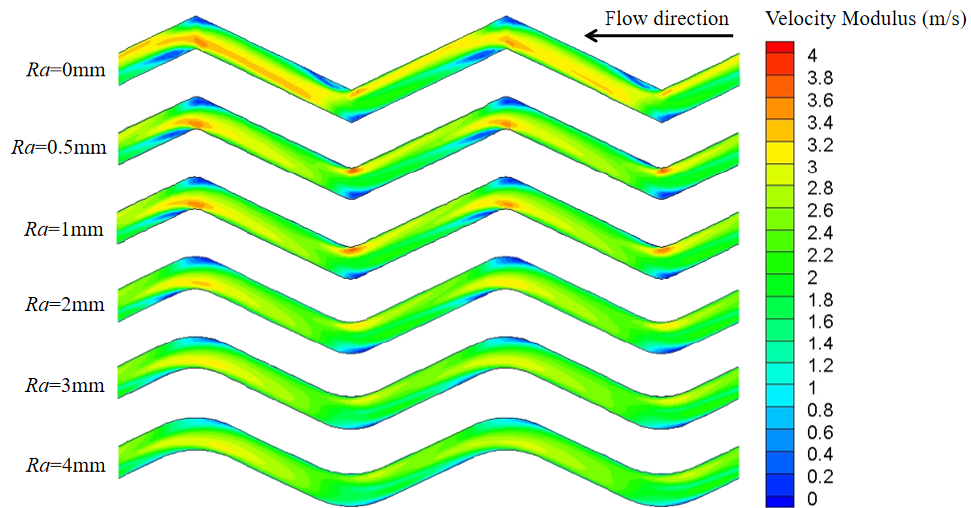
Figure 9. Velocity modulus for different curvature radii of inserted arc segments.